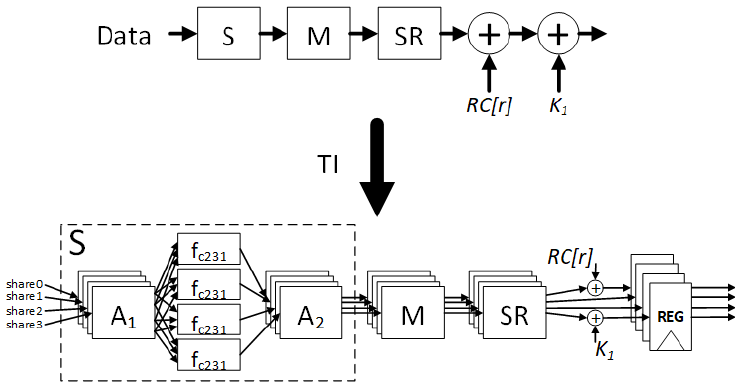
Figure 7. Directly TI of PRINCE.